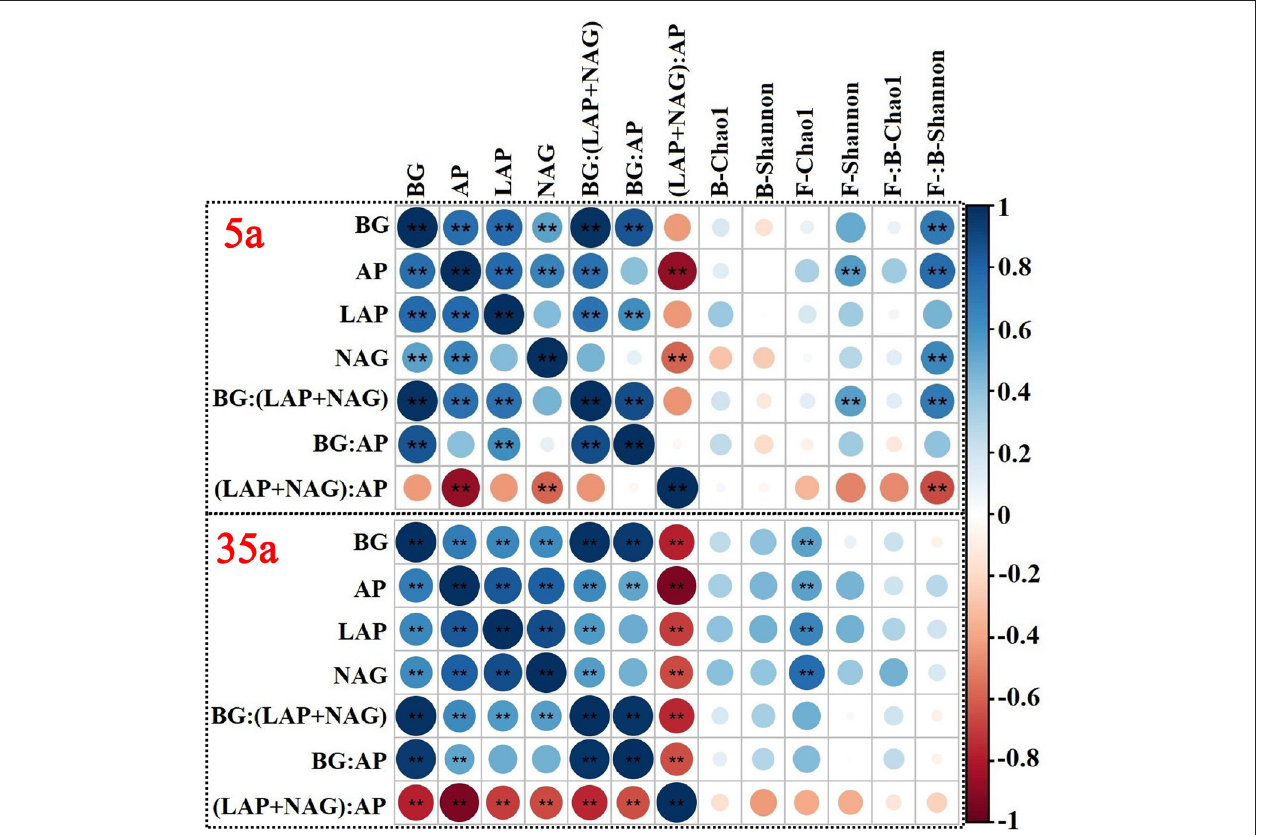
FIGURE 5 | Spearman’s rank correlation coefficients between enzyme activity and microbial alpha diversity (Chao1 and Shannon) in 5-year-old (top side) and 35-year-old (bottom side) plantations. BG, β -glucosidase; LAP, leucine aminopeptidase, NAG, β -1,4-N-acetylglucosaminidase; AP, acid phosphatase; B, bacteria; F,